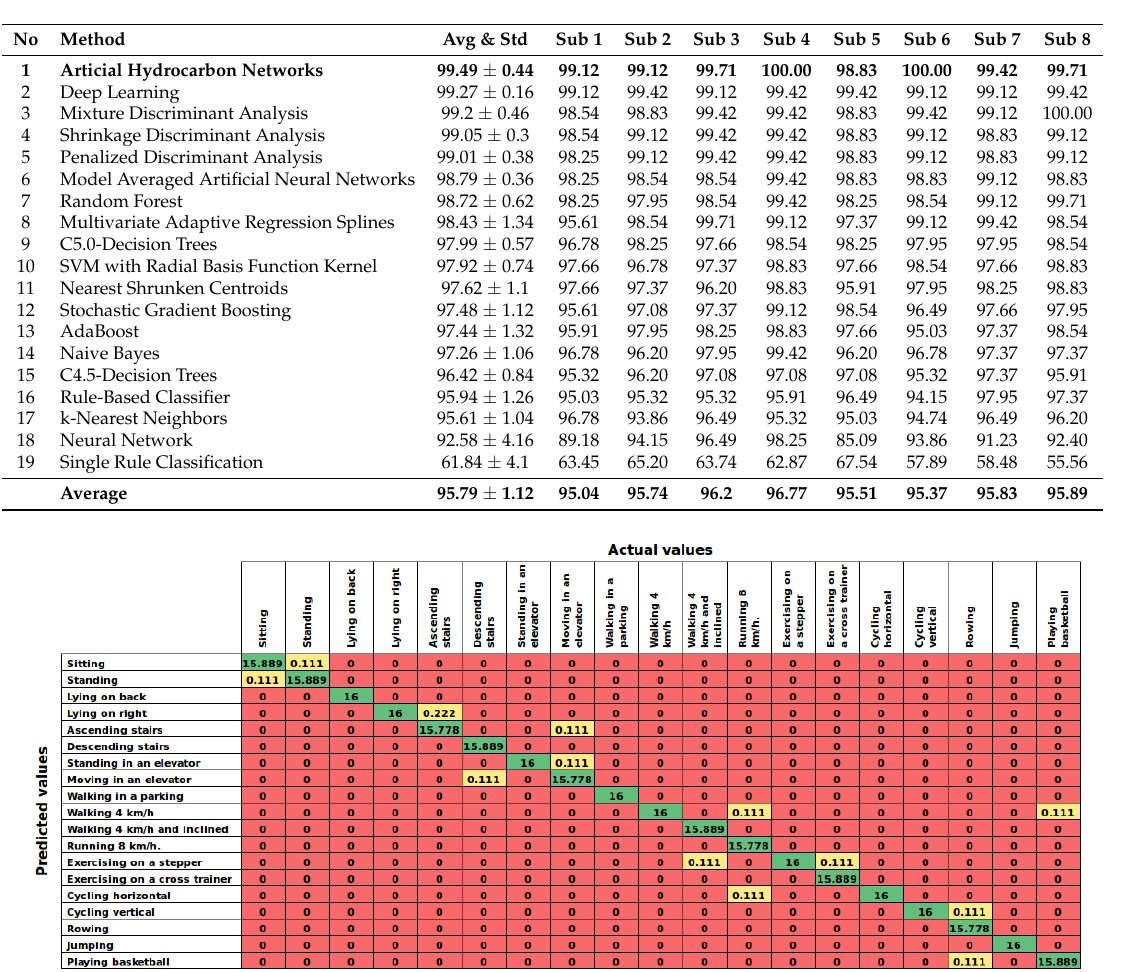
Table 10. Results of case 3: Cross-validation within a subject performance for the user-dependent approach for each of the models created.